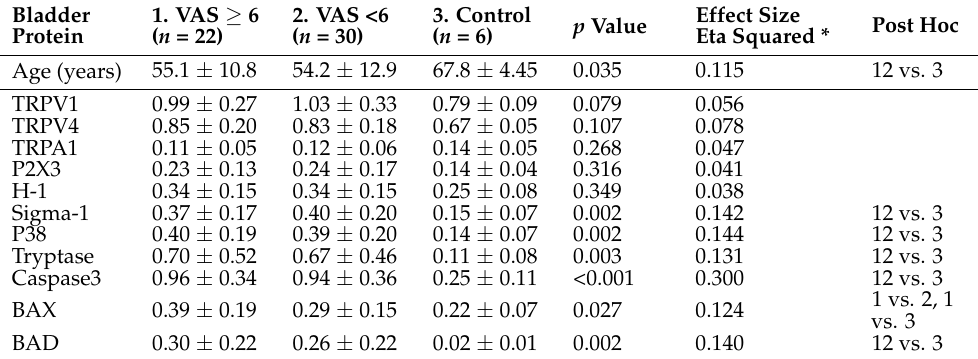
Table 6. Sensory, inflammatory, and pro-apoptotic protein expression levels in the urothelium of patients with interstitial cystitis/bladder pain syndrome with different bladder pain severity and controls.